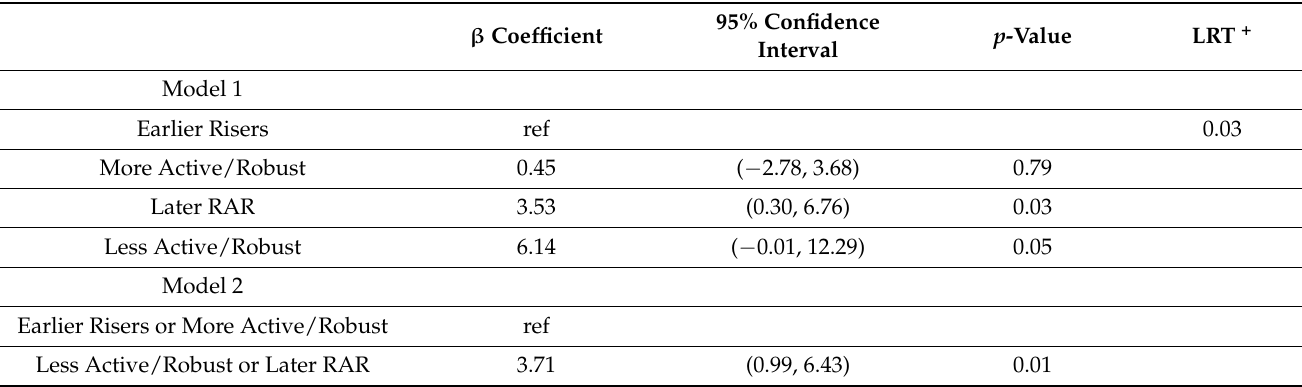
Table 4. Multivariable quantile regression of effects of rest–activity rhythm (RARs) profiles on median Pittsburgh Fatigability Scale Physical scores